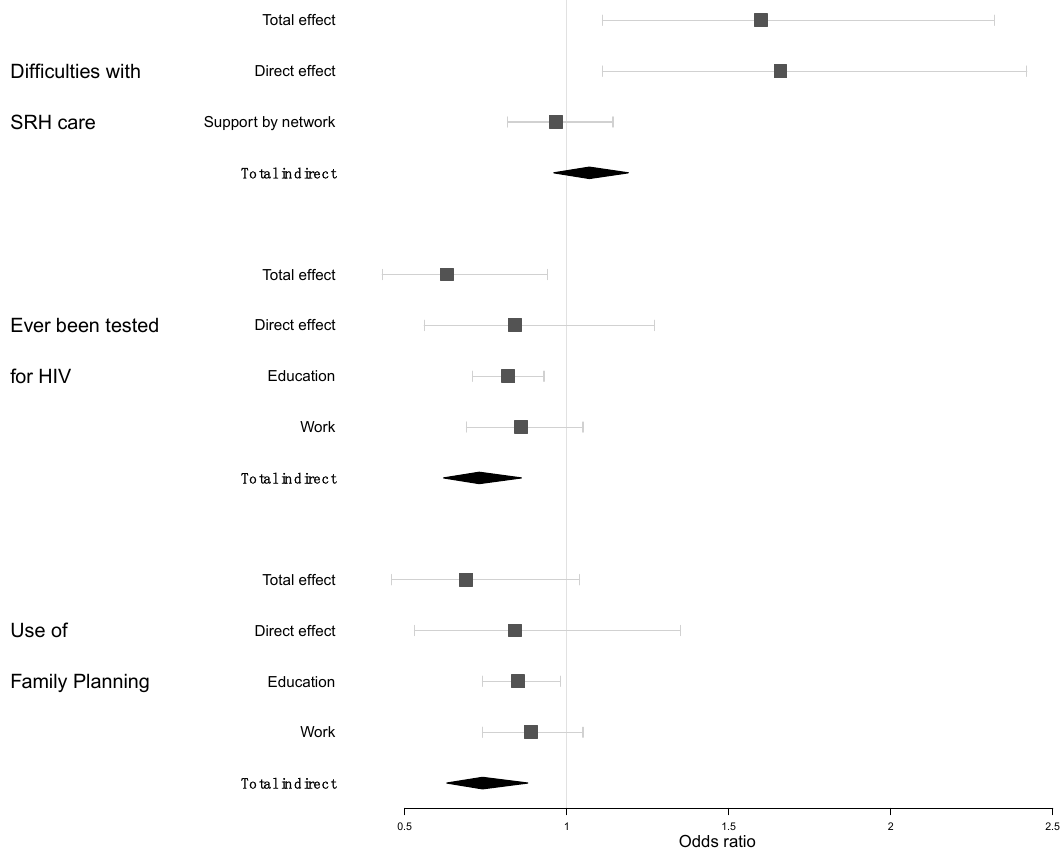
Figure 4. Total, direct and mediated association between disability and access to sexual and reproductive health services outcomes (vertical line indicates null effect).